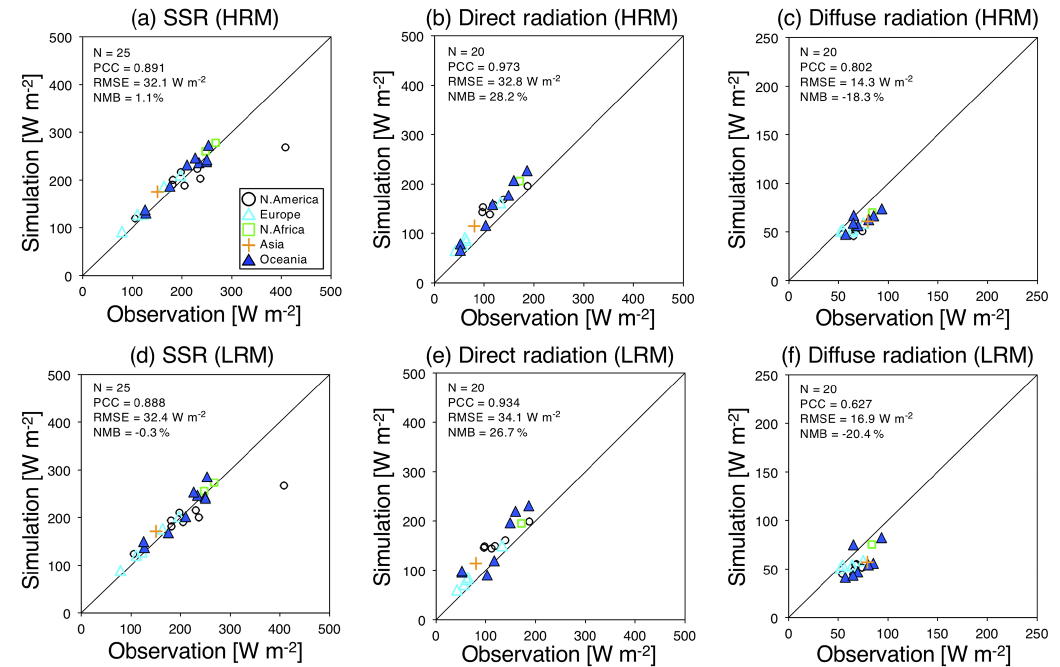
Figure 4. Scatterplots of the (a, d) surface solar radiation (SSR), (b, e) direct and (c, f) diffuse radiation fluxes between the BSRN measure- ments and NICAM simulations (HRM and LRM) for global annual averages. The different colors and marks reflect the sites in the different regions explained in panel (a) . The numbers located in the upper-left corner in each panel represent the statistical metrics: the sampling number ( N ), PCC, RMSE and NMB. All units are in Wm − 2